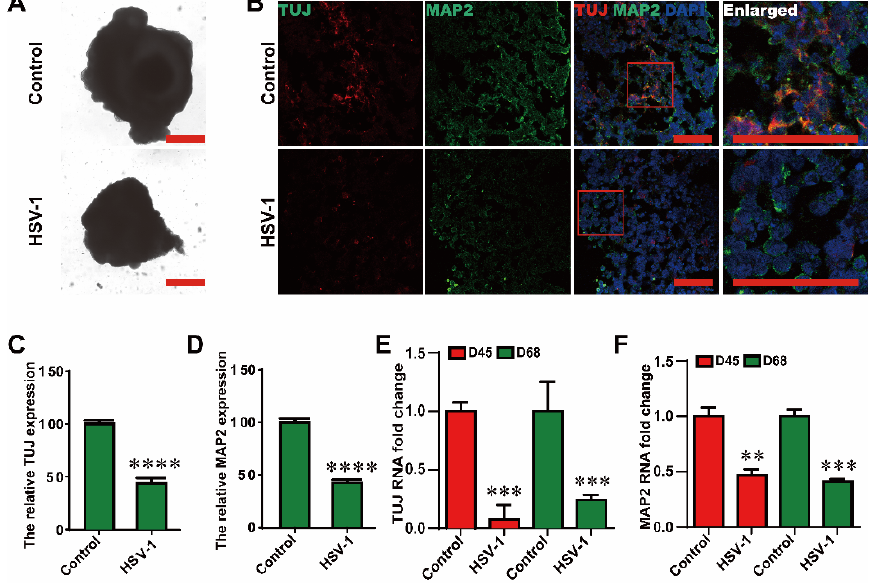
Figure 3. HSV-1 infection resulted in the neuron loss. ( A ) The bright field images of cerebral organoids with or without HSV infection (D65 + 3), the red frame line is the position of the enlarged figure. Scale bars (red rectangle): 1 mm. ( B ) Co-immunostaining of TUJ and MAP2 were identified by immunofluorescence in the HSV-1 infected cerebral organoids at D65 + 3, Scale bars (red rectangle): 100 µ m. ( C , D ) The relative fluorescence intensity statistics of TUJ and MAP2 expressions were shown in different groups. ( E , F ) RT-PCR analysis to monitor the mRNA expressions of TUJ and MAP2 in HSV-1-infected cerebral organoids at D42 + 3 and D65 + 3. The expression value was normalized to the GAPDH expression level. Data represent the mean ± SEM. ** p < 0.01 vs. the control group, *** p < 0.005 vs. the control group, **** p < 0.001 vs. the control group, ( n =